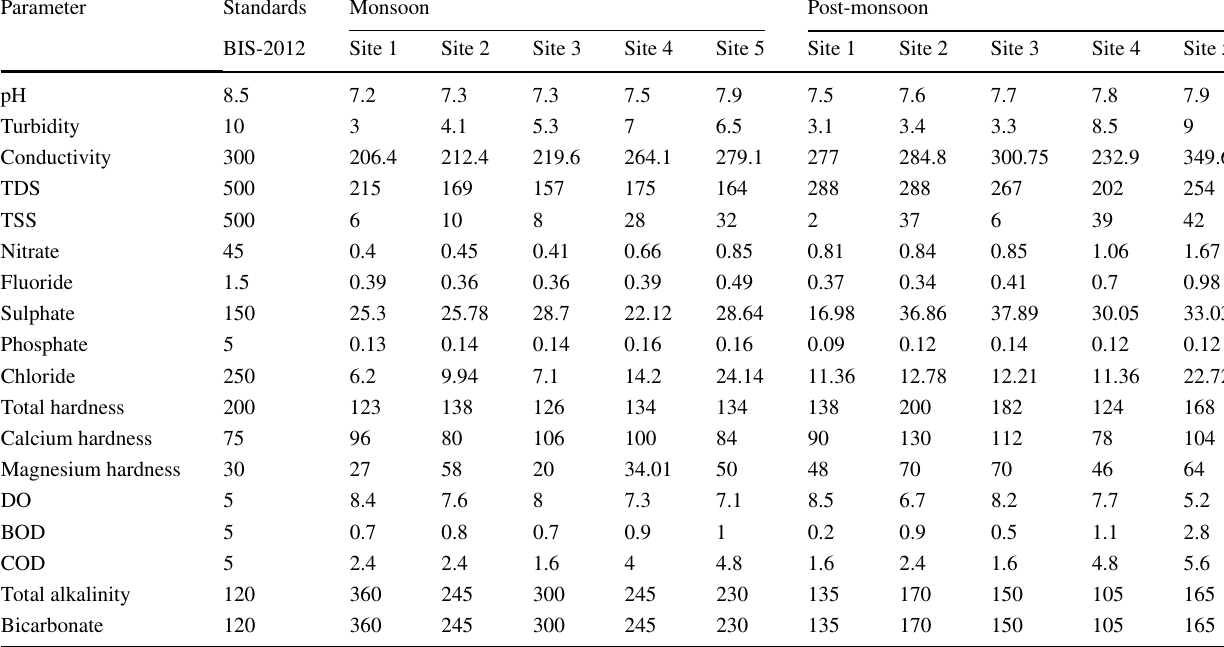
Table 3 Results of analysed physico-chemical parameters in monsoon and post-monsoon period Parameter